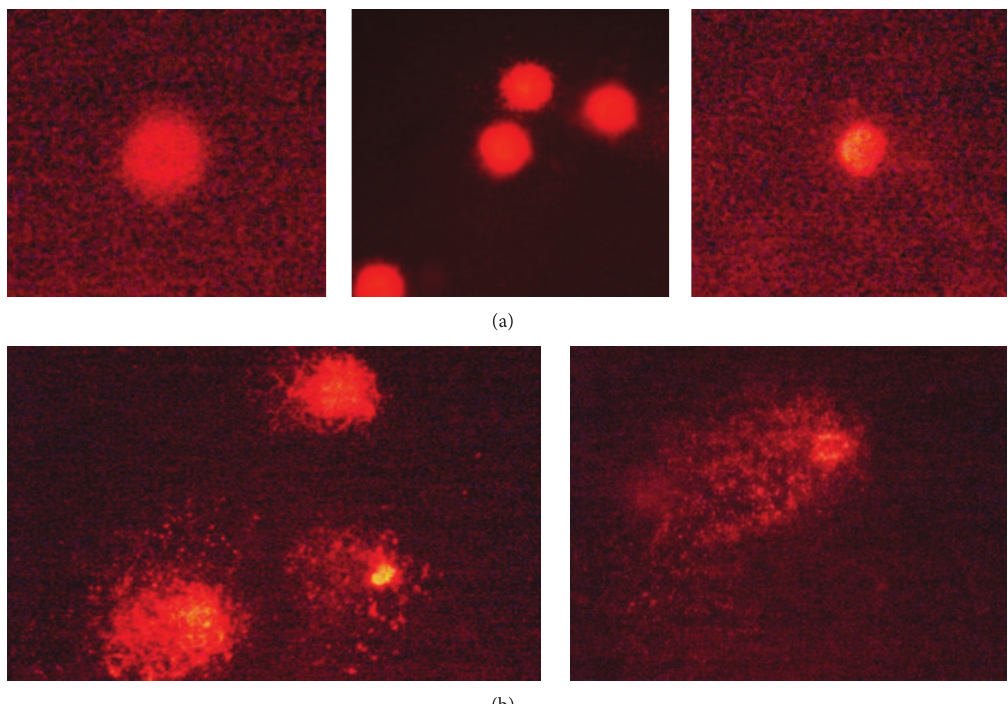
Figure 5: Evaluation of genotoxic effect induced by different extracts obtained from A. aroma . (a) Hot aqueous extract of A. aroma (1, 5, and 20 mg/mL): nucleoids without genotoxic damage (category 0). (b) Ethanolic and hot aqueous extracts of A. aroma at the highest concentration (20 mg/mL): nucleoids with mild damage (category